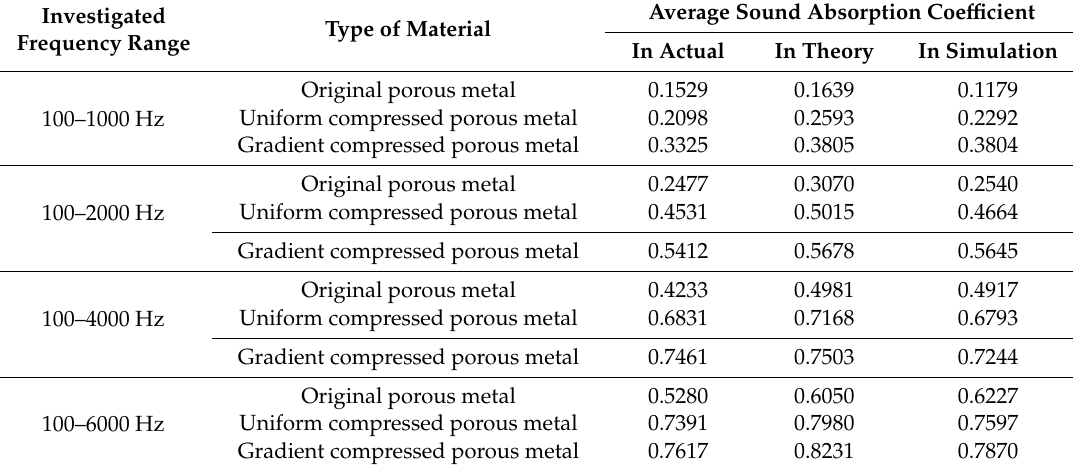
Table 2. Comparisons of average sound absorption coe ffi cients of the optimal 10-layer gradient compressed porous metal and those of original porous metal and the uniform compressed porous metal.